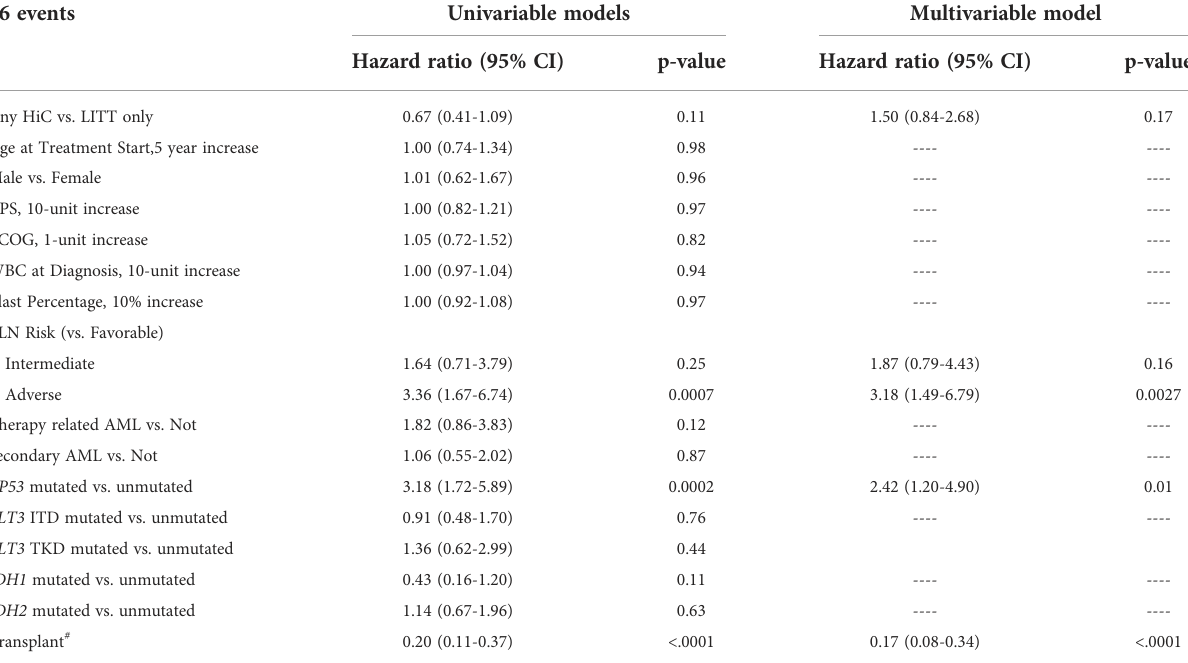
TABLE 3 Cox regression analysis of os from fi rst aml therapy (N=127).